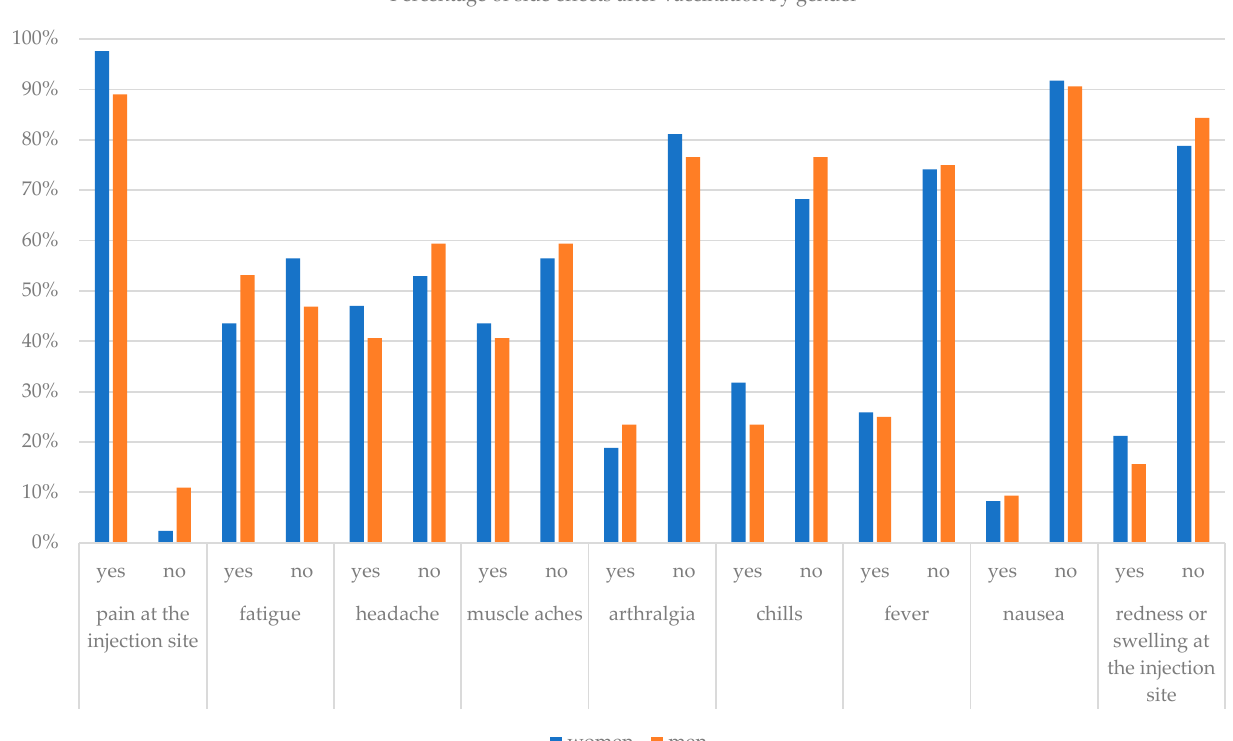
Figure 4. Comparison of the number of side effects after taking the vaccine with gender.